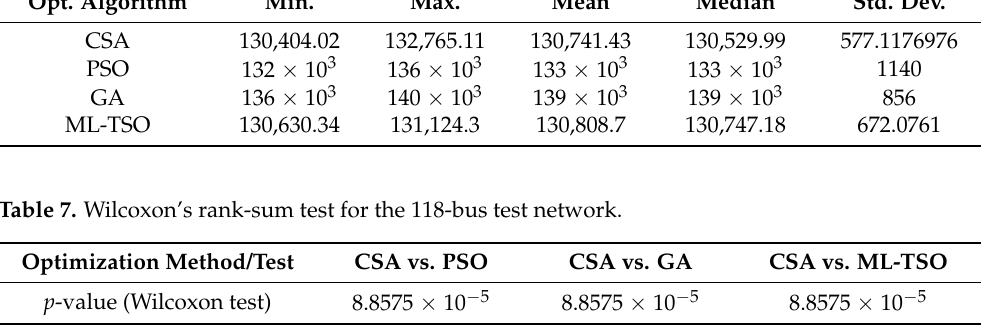
Table 6. The CSA, GA, and PSO statistical analysis results for the 118-bus system. Opt. Algorithm Min. Max. Mean Median Std. Dev.